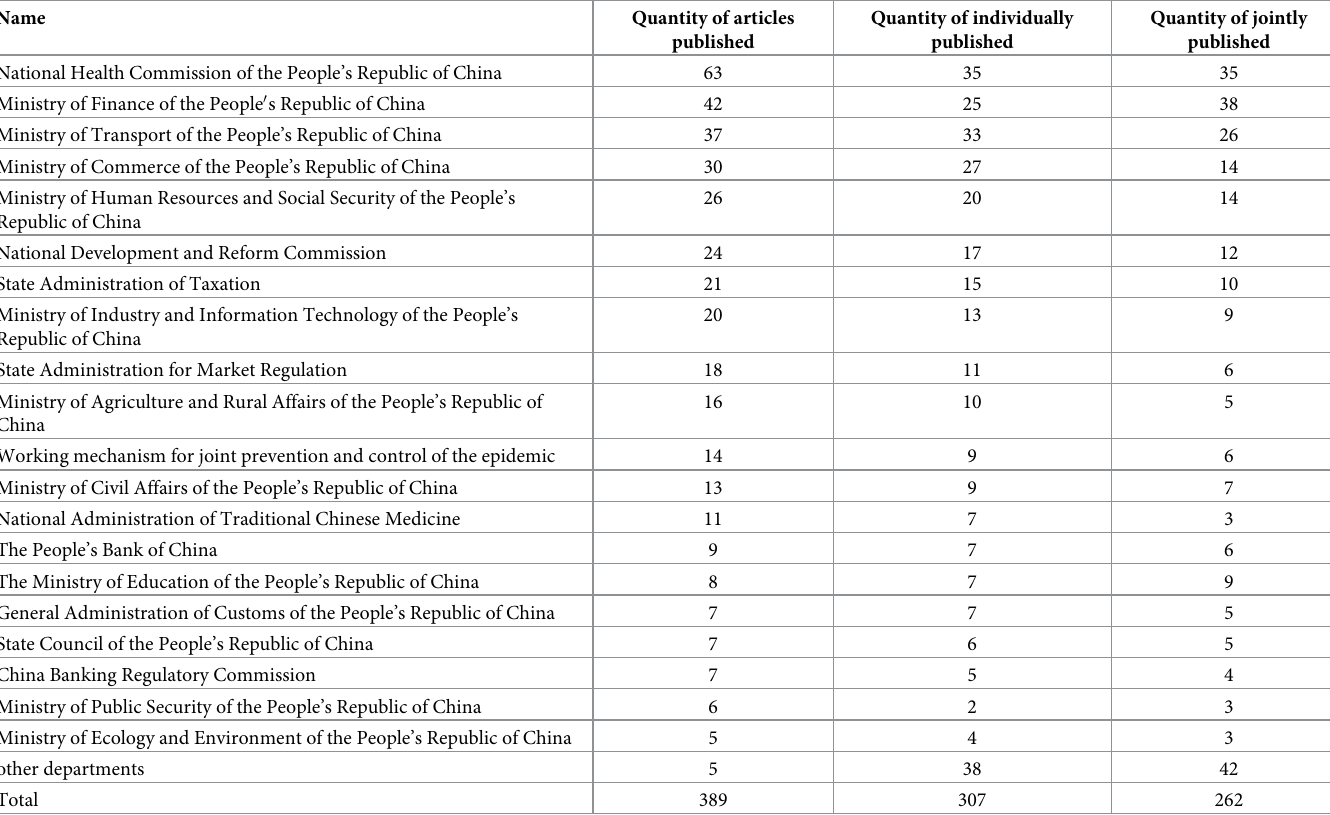
Table 4. Policy issued department